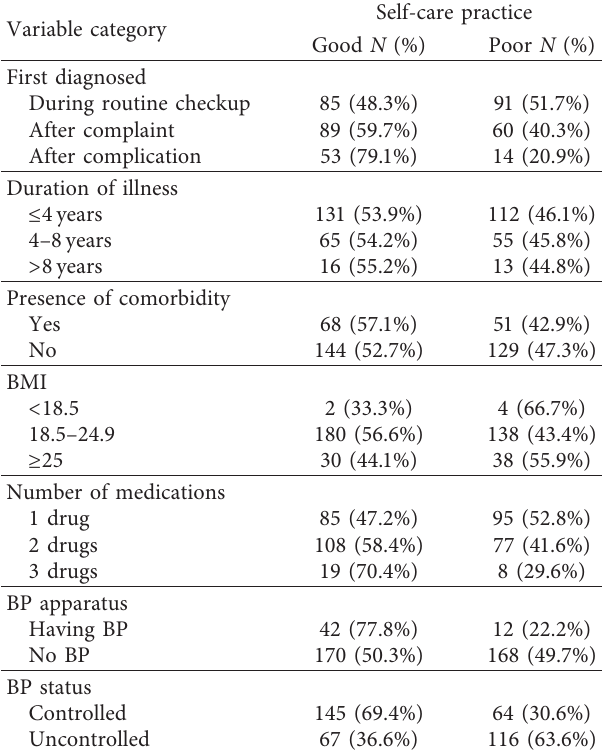
Table 2: The clinical related health profiles of hypertensive patient on Debre Tabor Referral Hospital, Northwest Ethiopia, 2020.